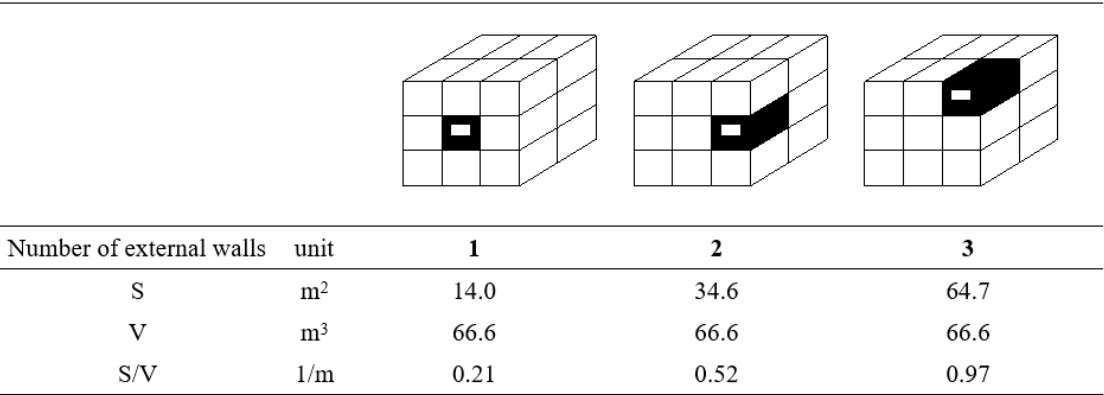
Figure 1. Different S/V ratio of the analyzed room.